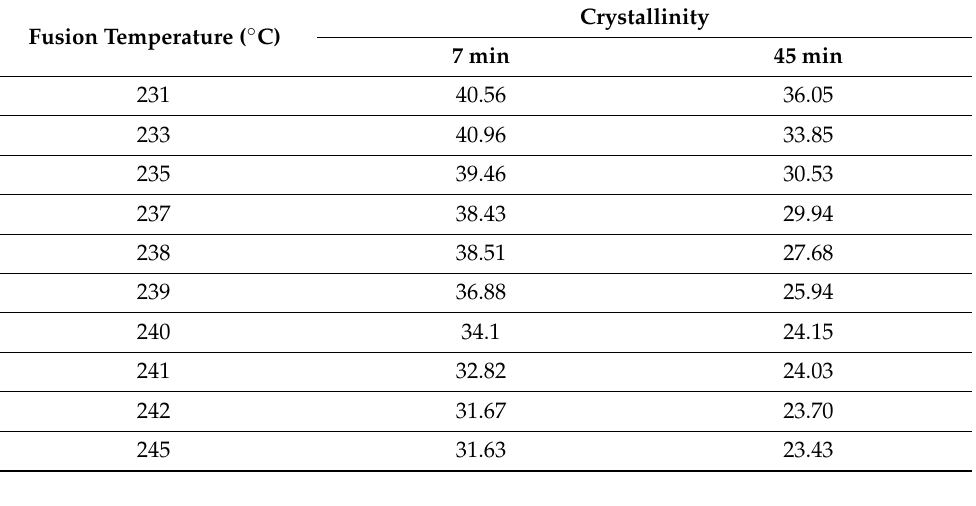
Table 4. Crystallinity of PA6 at di ff erent fusion times.